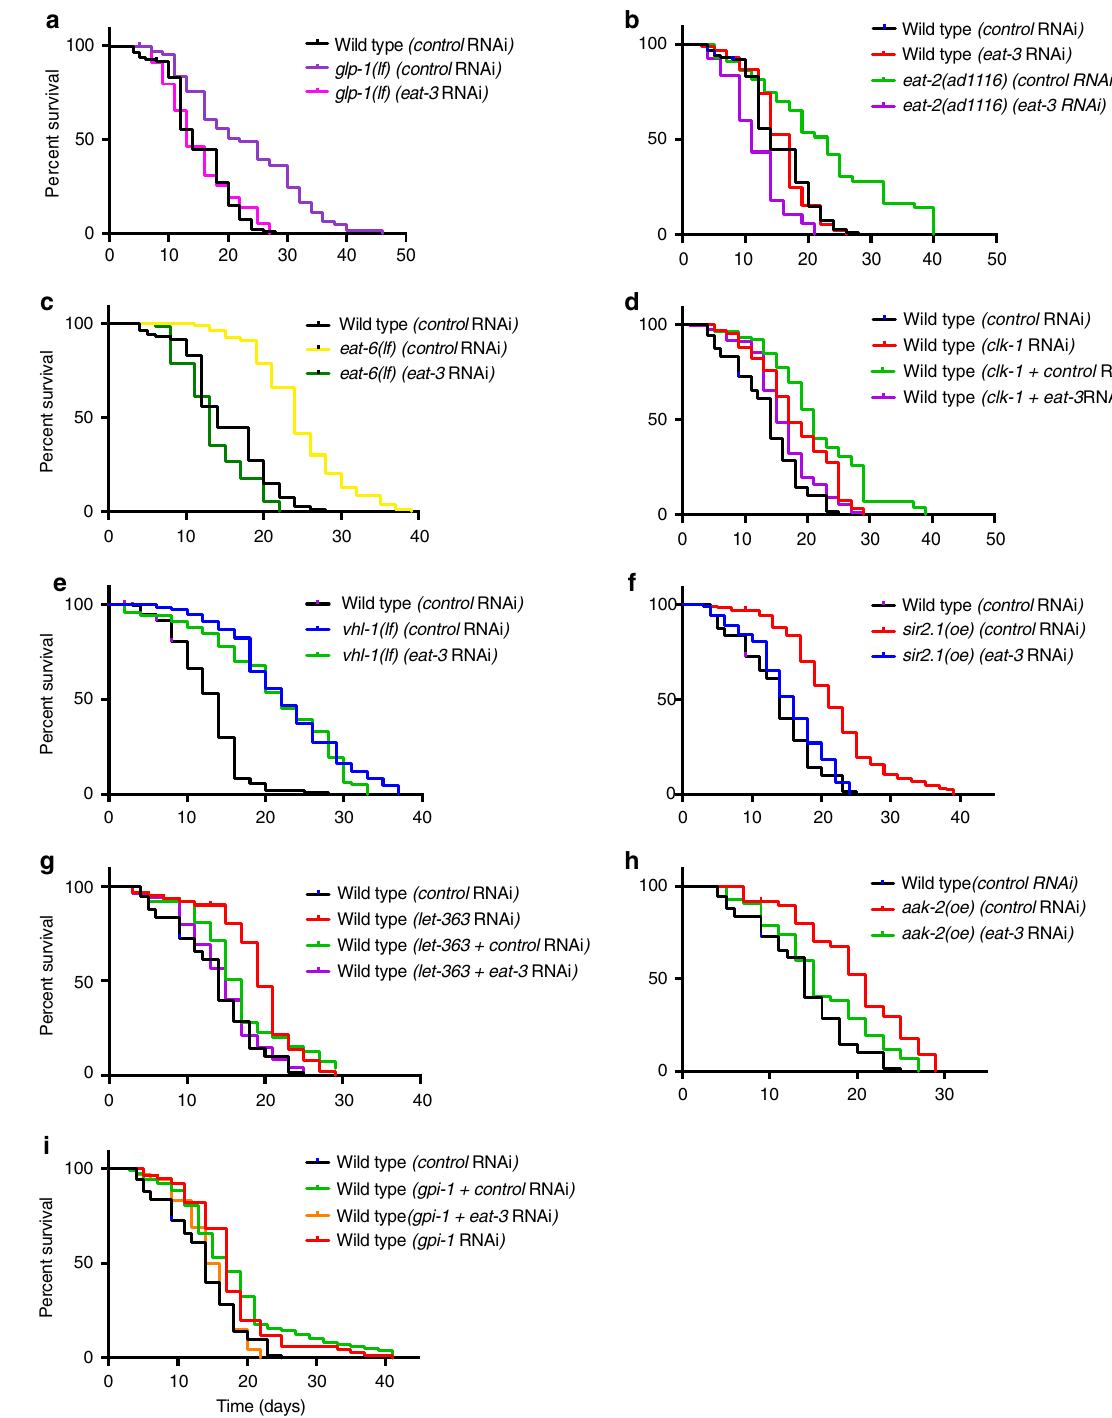
Fig. 9 Mitochondrial elongation is required for longevity in diverse mutants. a – i Survival curves for adults of the indicated genotypes, overexpressions (oe), and RNAi treatments. The wild-type and eat-3(RNAi) survival curves are shown in graphs for comparison. eat-3 RNAi signi fi cantly reduced the extended lifespans relative of all tested genotypes, overexpression, and RNAi treatments except for vhl-1 mutants and wild-type control e . All lifespan experiments were performed with four biological replicates. See Supplementary Table 2 for